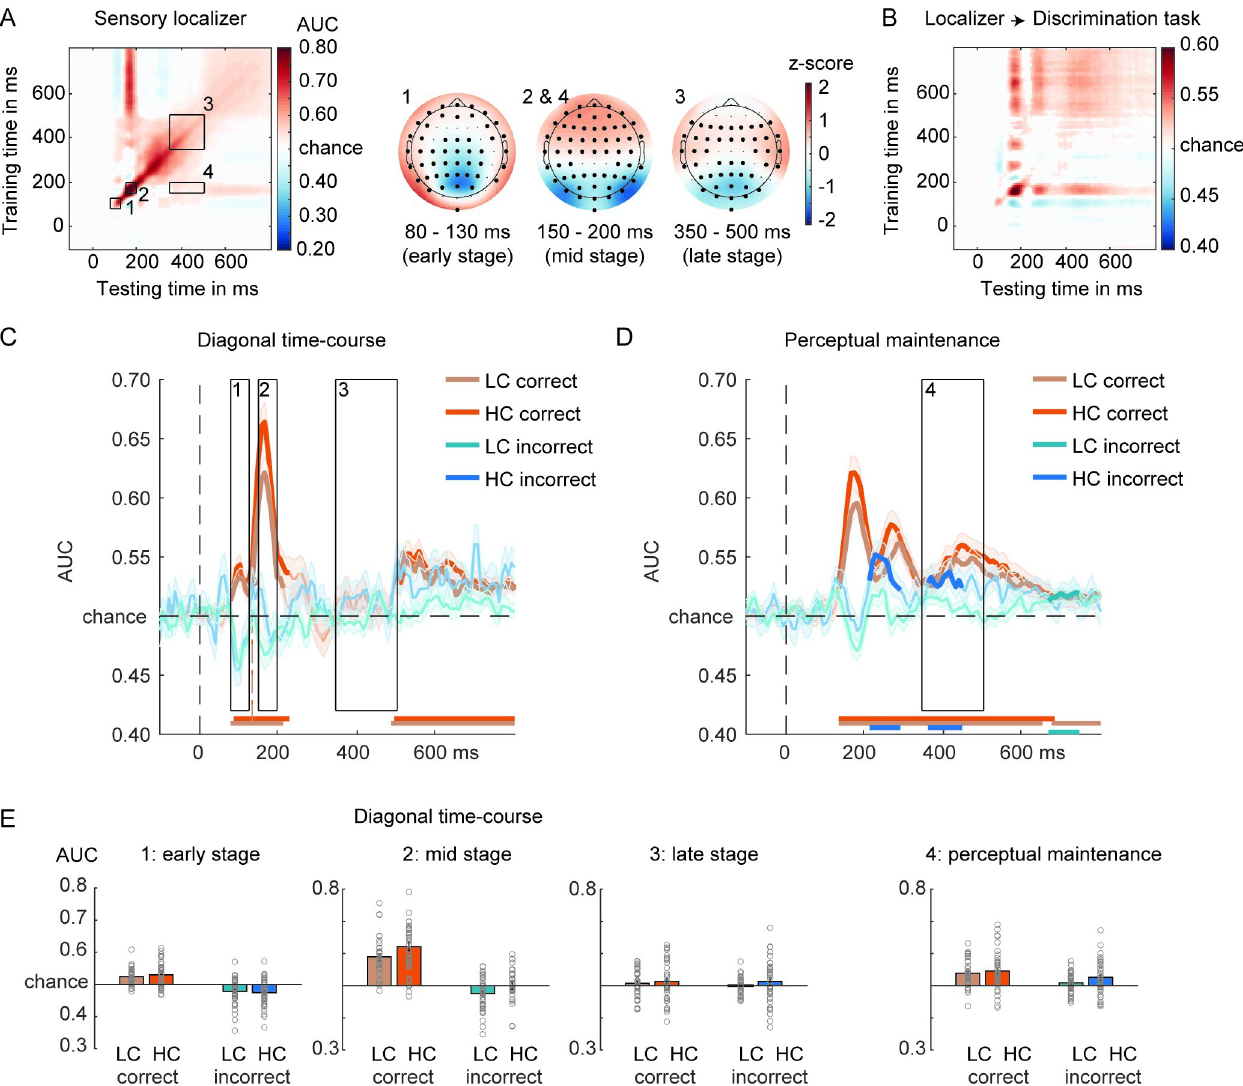
Fig 4. Face/house classification based on the sensory localizer. ( A ) GAT matrix for the sensory localizer (all electrodes) and ROI marked by inset black boxes (numbers 1–4). On the right, covariance/class separability maps for each diagonal ROI, indicating the underlying data contributing to the classification performance. Highlighted channels significantly contributed to the classification performance after cluster-based permutation testing over channels (corrected for multiple comparisons). Covariance/class separability maps 2 and 4 are the same because decoding scores within insets 2 and 4 were obtained using the same training time-window. ( B ) Classifiers trained on the sensory localizer applied to the main discrimination task (cross-task validation procedure, all electrodes). ( C ) On-diagonal and ( D ) off-diagonal time courses of correct and incorrect decisions, separated by confidence. Black boxes indicate the time-windows (early, mid, late) used for averaging the AUC scores. Colored horizontal lines indicate periods of significant decoding with respect to chance. Longer-lasting sensory traces are derived by training a classifier on the time-window 150–200 ms and testing it across the entire time-window (panel D). Classification performance was evaluated at each time point using cluster-based permutation testing (two-tailed cluster-permutation, alpha p < 0.05, cluster alpha p < 0.05, N permutations = 1,000). ( E ) Bar plots show average AUC values for the TOI highlighted in panels (C) and (D). The underlying data and scripts supporting this figure can be found on FigShare (https://doi.org/10.21942/uva.c.6265233.v1). AUC, area under the curve; GAT, generalization across time; HC, high confidence; LC, low confidence; ROI, regions of interest; TOI, time-windows of interest. For incorrect decisions, the early and mid-stage were also similar as compared to when the classifiers were trained on the decision localizer (early stage: LC: t = − 3.4, p = 0.002, d = 39 − 0.54; HC: t 39 = − 3.91, p < 0.001, d = − 0.62; mid-stage: LC: t 39 = − 3.04, p = 0.004, d = − 0.48; HC: t = − 0.11, p = 0.91, d = − 0.02, BF = 5.83). Specifically, we observed negative decoding 39 01